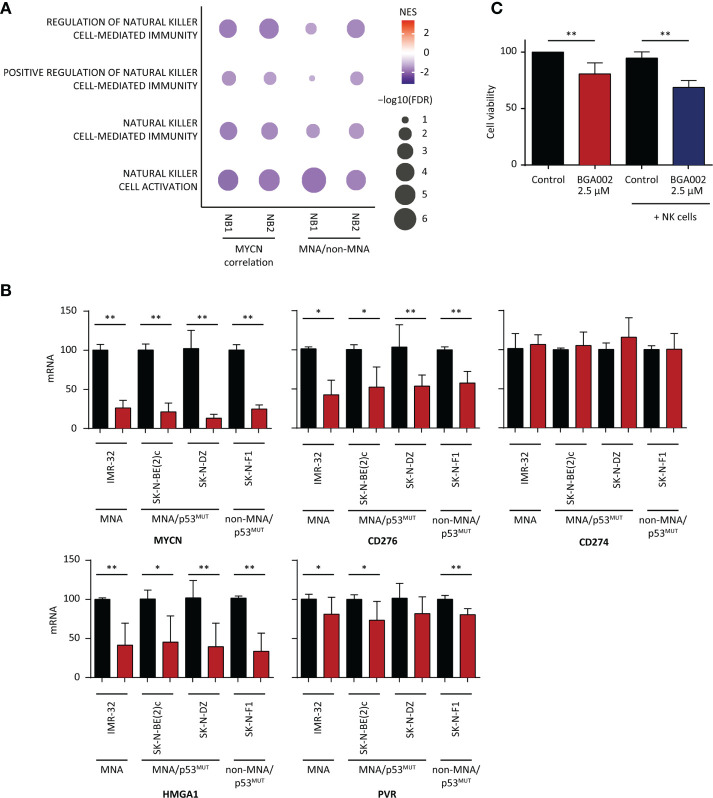
BGA002 blocks CD276 and restores neuroblastoma (NB) susceptibility to natural killer (NK) cells. (A) Pathway enrichment for four select immune pathways [Gene Ontology (GO) terms] associated to NK cells. (NB1: E-MTAB-1781, NB2: TARGET NB). Symbol size and color intensity indicate—log10 FDR and NES. GO terms enriched in MYCN (left) anti-correlated genes and GO terms enriched in non-MYCN amplification (MNA) (right) patients. (B) mRNA expression inhibition of different genes (MYCN, CD276, CD274, HMGA1, PVR) in NB cell lines measured through real-time PCR after 12 h of treatment with BGA002 2.5 µM (black is the control, red the treatment, n = 4 biological replicates for each cell line). Wilcoxon matched pair test; *P < 0.05, **P < 0.01, where not shown is not significant (P > 0.05). (C) Kelly-luc cell line (MNA NB cell line transfected with luciferase) viability after treatment with BGA002 2.5 µM and NK co-culture (five independent experiments). Wilcoxon matched pair test; **P < 0.01.